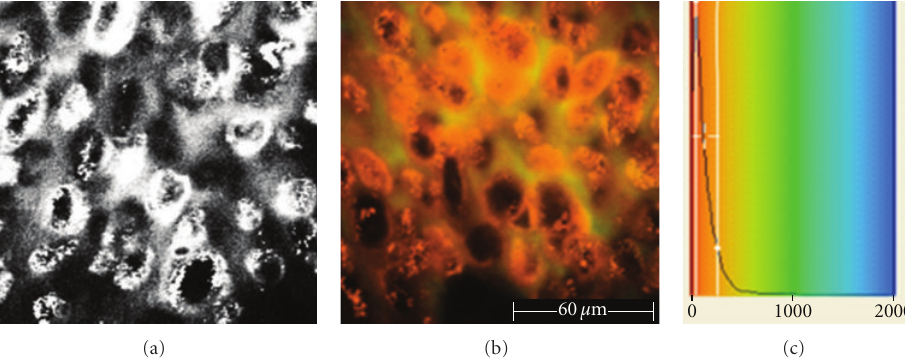
Figure 6: Malignant melanoma examined ex vivo , 40 μ m depth, 760 nm excitation wavelength. (a) Grey scale image acquired by the DermaInspect. We observe an irregular distribution of pleomorphic cells with di ff erent shape and size. (b) FLIM image acquired by the DermaInspect equipped with the Imperial College FLIM system. Melanoma cells contain melanin and appear yellow (short lifetime values). (c) The diagram shows the fluorescence lifetime on the x axis (from 0 to 2000ps) and the number of pixels corresponding to the fluorescence lifetime on the y axis.